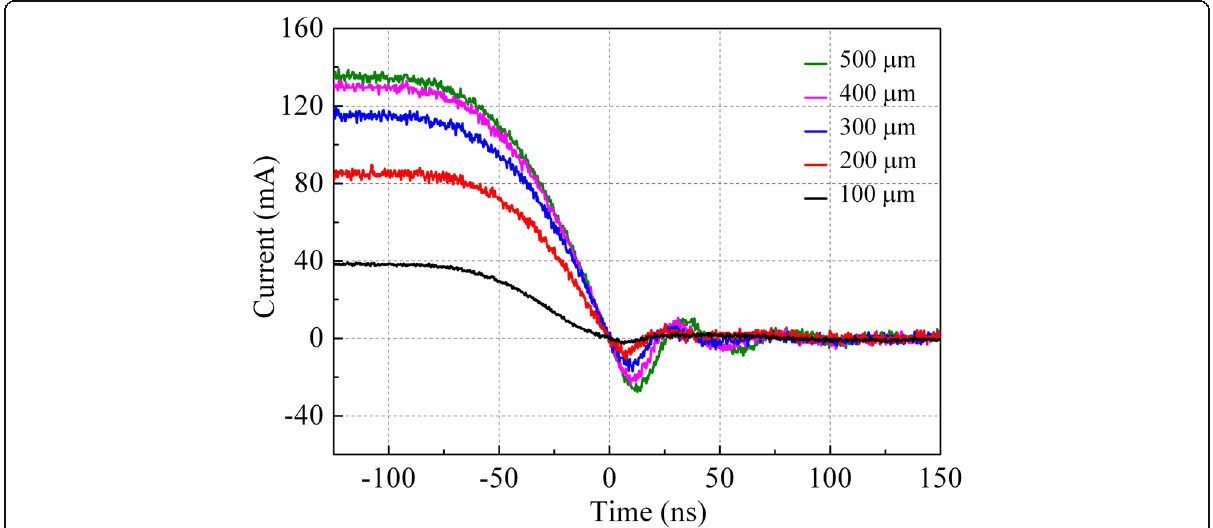
Fig. 4 Reverse recovery current of vertical SBDs for each different electrode